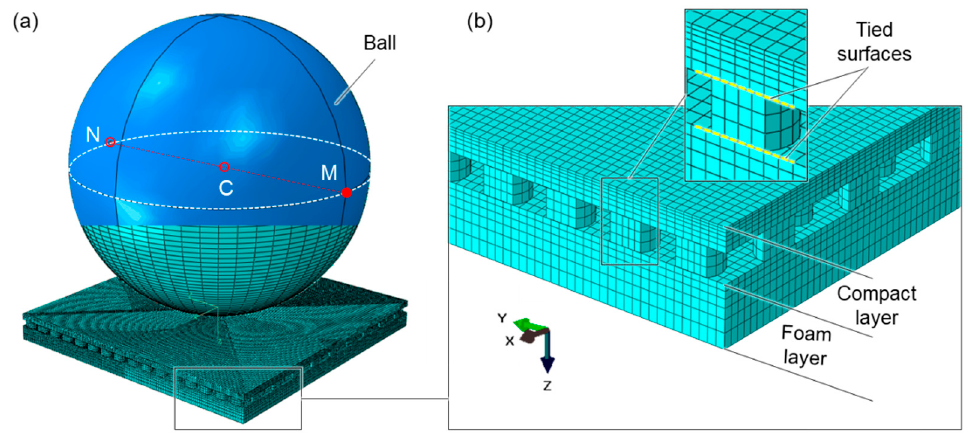
Figure 7. Finite element modeling (FEM). ( a ) 3D model and associated meshes. ( b ) Details on the foam + compact modeling.